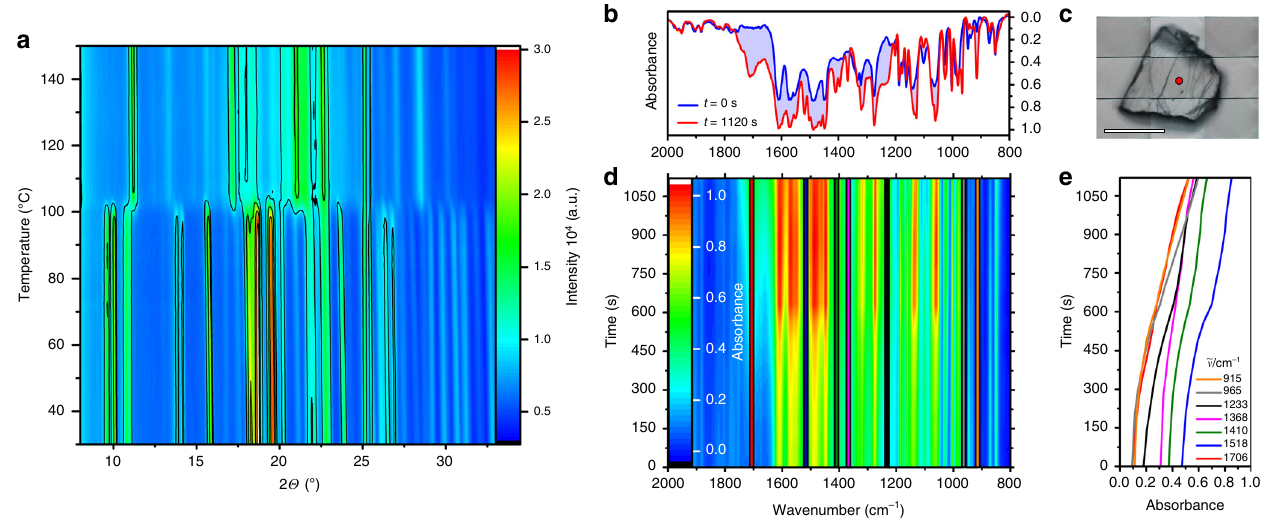
Fig. 2 μ IR spectra and powder XRD analysis of decomposition of LHP. a Variable-temperature powder X-ray diffraction pattern of LHP heated from room temperature to 150 °C. b The 2000 ‒ 800 cm ‒ 1 region in the IR spectrum before (blue line) and after heating to 115 °C for 1120 s (red line). c Optical image of the LHP crystal used to record the μ IR spectrum (the red circle indicates the position of the incident IR beam). The scale bar corresponds to 50 μ m. d Time-pro fi le of the IR spectrum of LHP at 115 °C. e Isothermal kinetic traces at selected wavenumbers (highlighted in d ) used in the kinetic